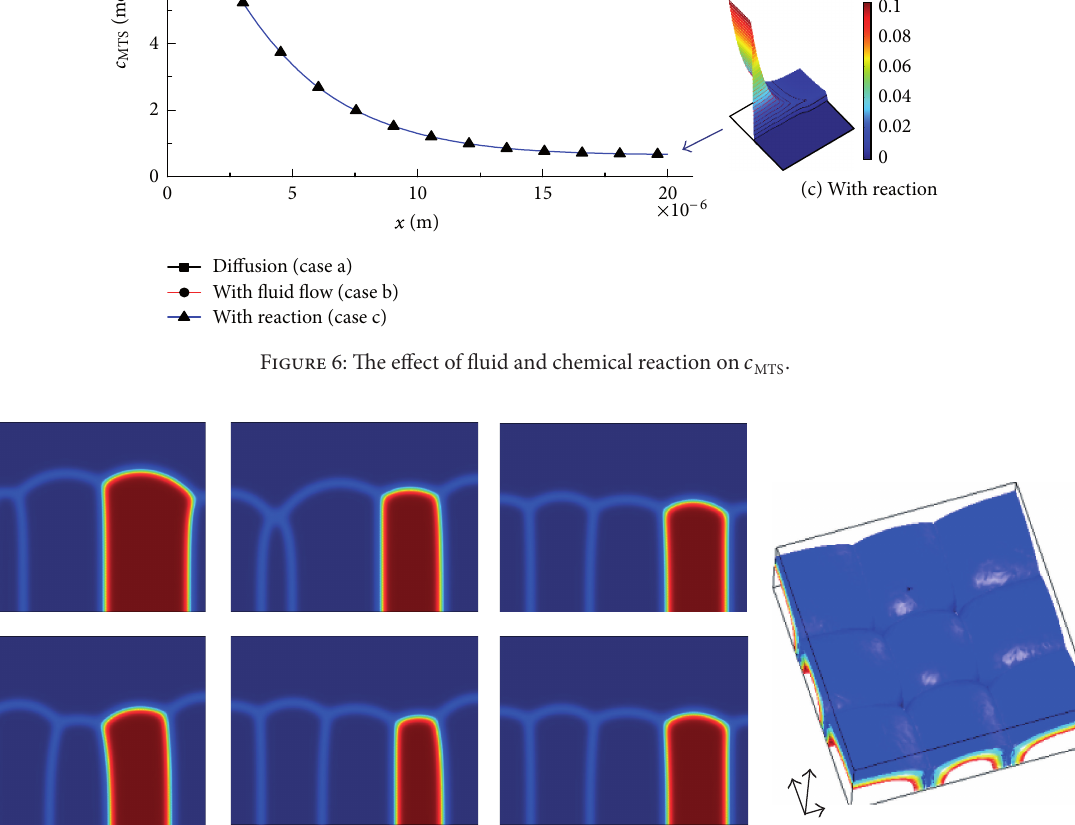
F 7: SiC deposited as